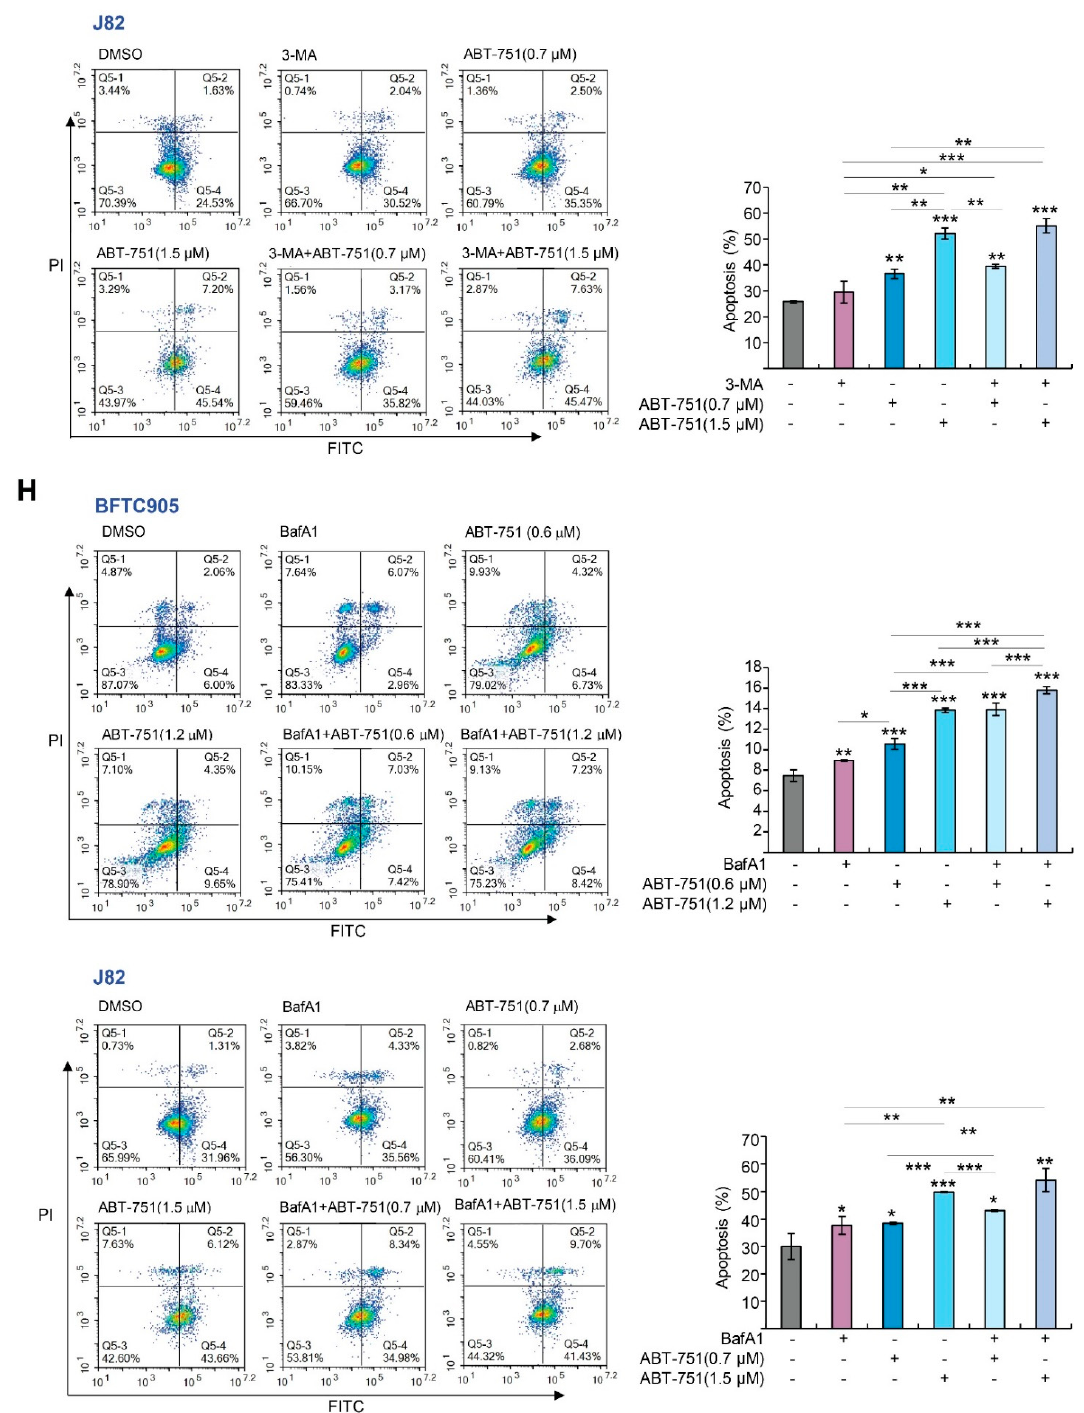
Figure 3. ABT-751 induces autophagy accompanied by the mechanistic target of rapamycin kinase (MTOR) downregulation and apoptosis via both extrinsic and intrinsic pathways in the UBUC cells. ( A ) BFTC905 cells (up) and J82 cells (down) were treated with different concentrations of ABT-751 (BFTC905, 0.6 and 1.2 µ M; J82, 0.7 and 1.5 µ M) for 24 h, and Autophagic flux was monitored by the Cyto-ID ® Autophagy Detection Kit; starvation (containing 2% fetal bovine serum (FBS) in culture medium) served as a positive control. ( B ) BFTC905 and J82 cells were treated with a specified concentration of ABT-751 (0.6 and 0.7 µ M, respectively) and the levels of various autophagy-related proteins were investigated by immunoblots. ( C ) The mRNA level of MTOR was examined by quantitative RT-PCR in both BFTC905 and J82 cells. ( D ) The UBUC-derived cell lines were treated with the indicated concentration of ABT-751 (BFTC905, 0.6 µ M and J82, 0.7 µ M), and the levels of apoptosis-associated proteins were determined by immunoblots. ( E ) The mRNA level of FAS was determined by